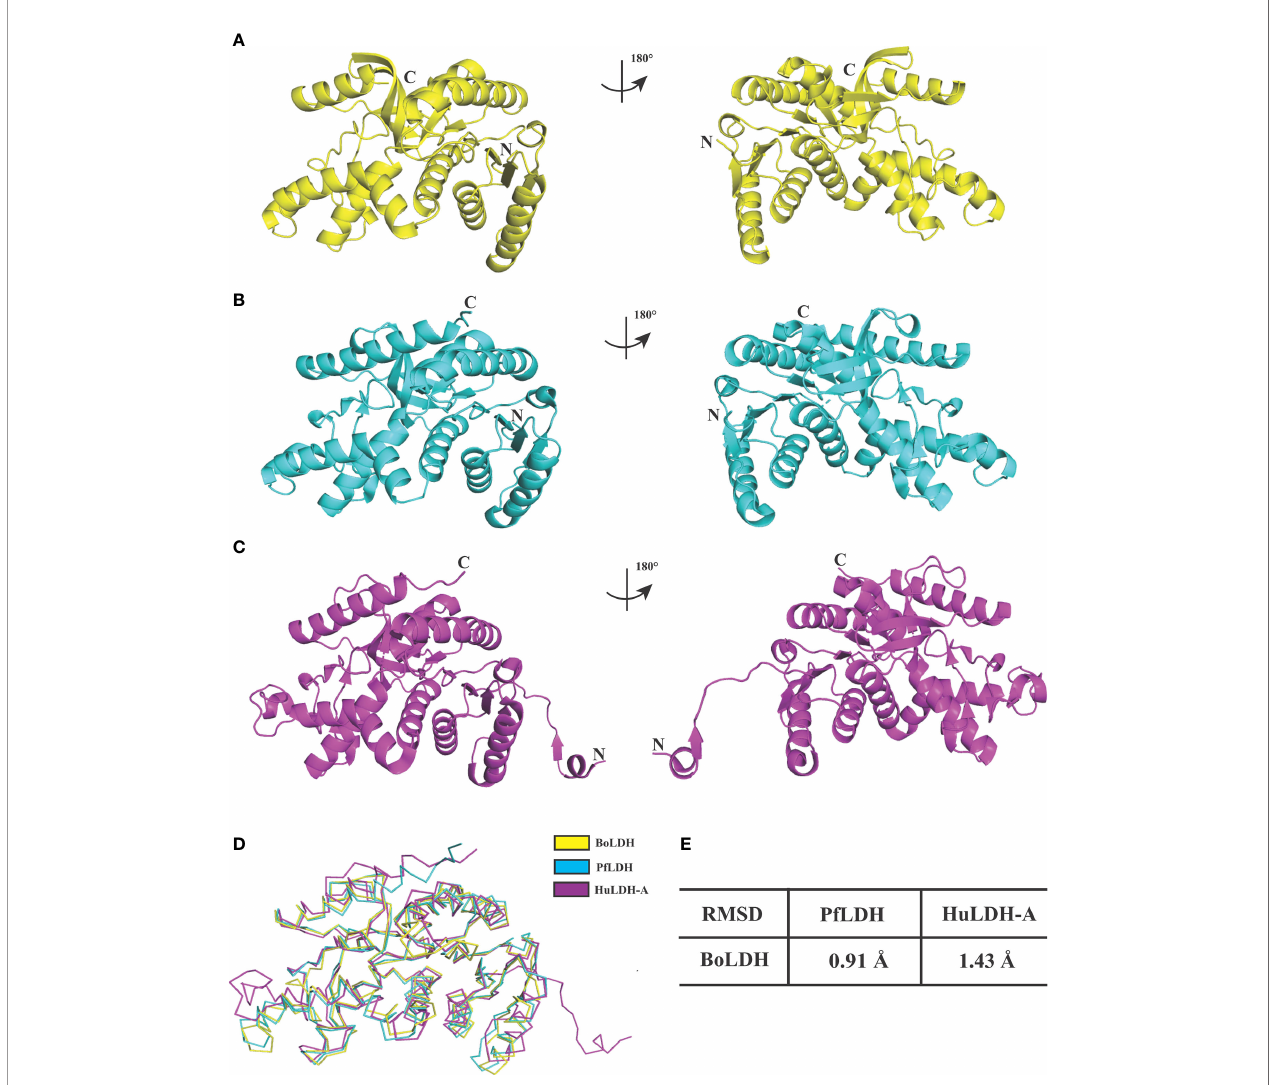
FIGURE 8 | Structural comparisons of BoLDH, PfLDH and HuLDH-A. (A) Overlay of BoLDH structure at 180 degrees. (B) Overlay of PfLDH structure at 180 degrees (PDB accession number 2x8l). (C) Overlay of HuLDH-A structure at 180 degrees (PDB accession number 4ojn). Structures of the three LDHs were exhibited in an identical orientation as cartoons, and colored in yellow, cyan and purple. (D) Ribbon diagrams of the three LDH structures. (E) Structure identities and RMSD values between BoLDH and PfLDH or between BoLDH and HuLDH-A were shown in the form. The RMSD values were calculated using the PDBeFold